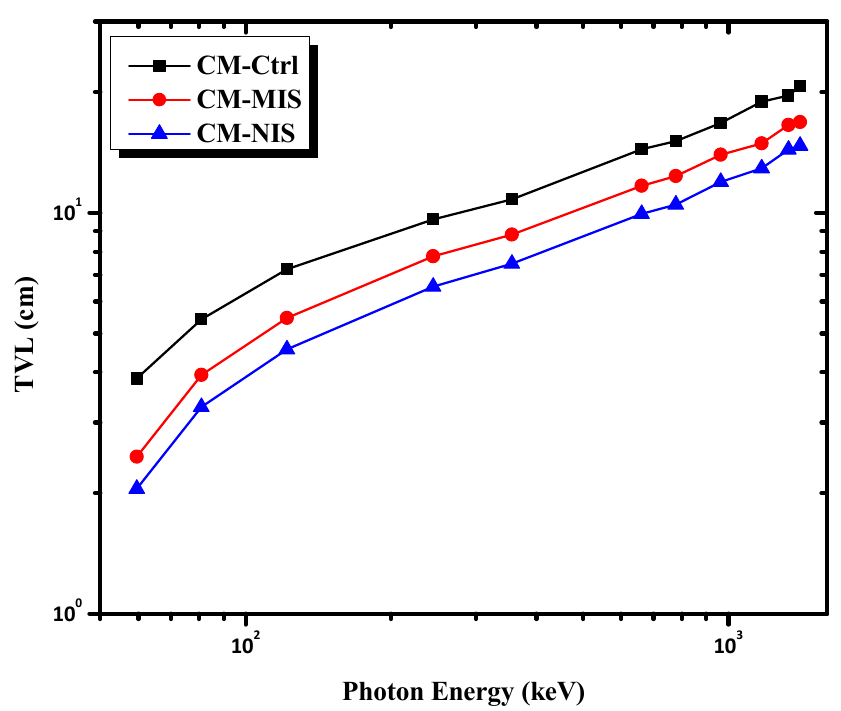
Figure 9. The variation of the HVL as a function of photon energy.